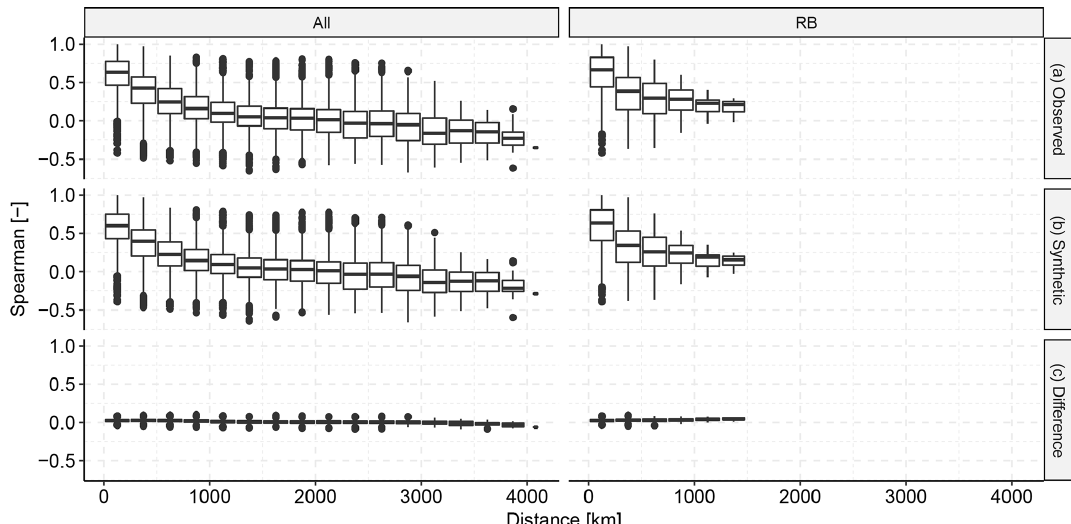
Figure 8. Spatial correlation of the observed descriptors vs. the synthetic descriptors, summarised by pairwise Spearman correlation. Panel (a) shows the correlation in the observed data, (b) shows the correlation in the synthetic data and (c) shows the difference between the observed and the synthetic correlation for each pair. The left column shows the correlation between all pairs of locations. The right shows only the pairs that are in the same river basin.